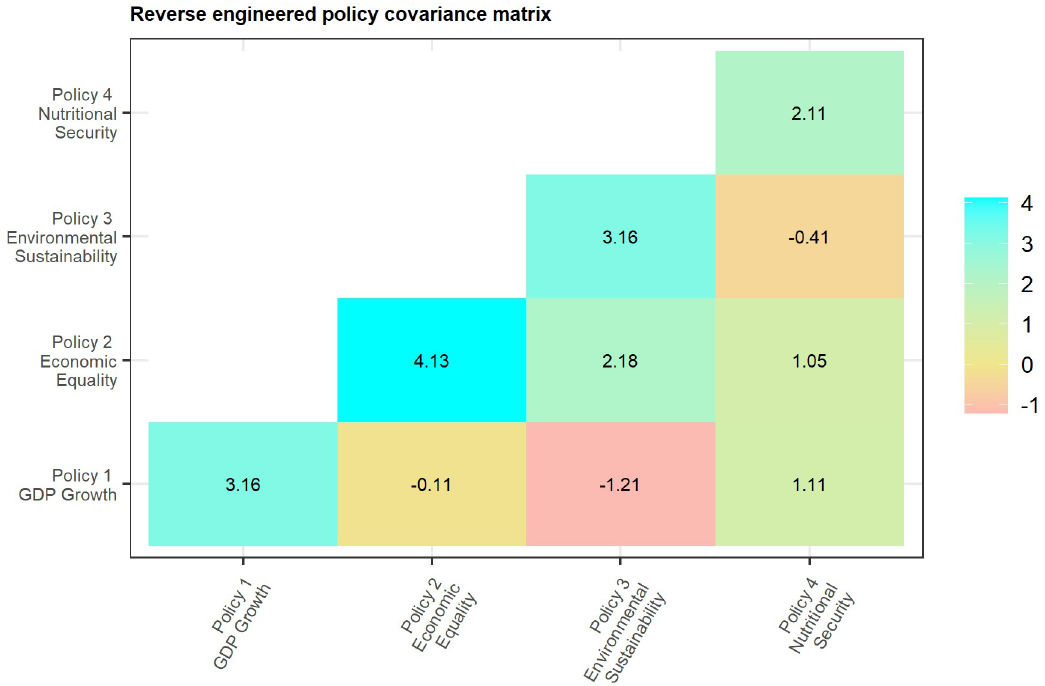
Fig 8. Policy covariance matrix calculated from the crowdsourced policy-project